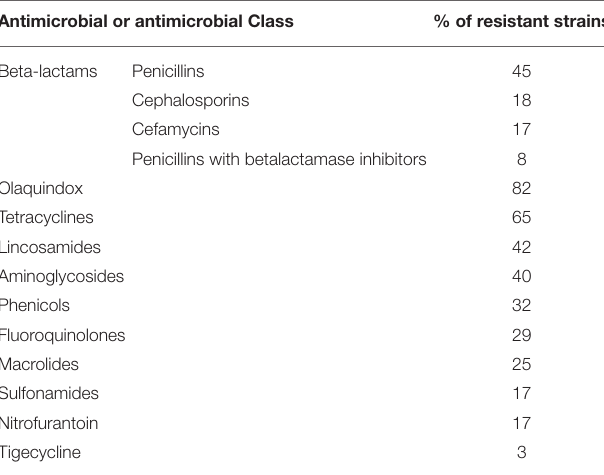
TABLE 1 | Cumulative results of antimicrobial resistance in E. coli isolated from pigeons, according to publications available in the PubMed database ( 18, 21–30). Antimicrobial or antimicrobial Class % of resistant